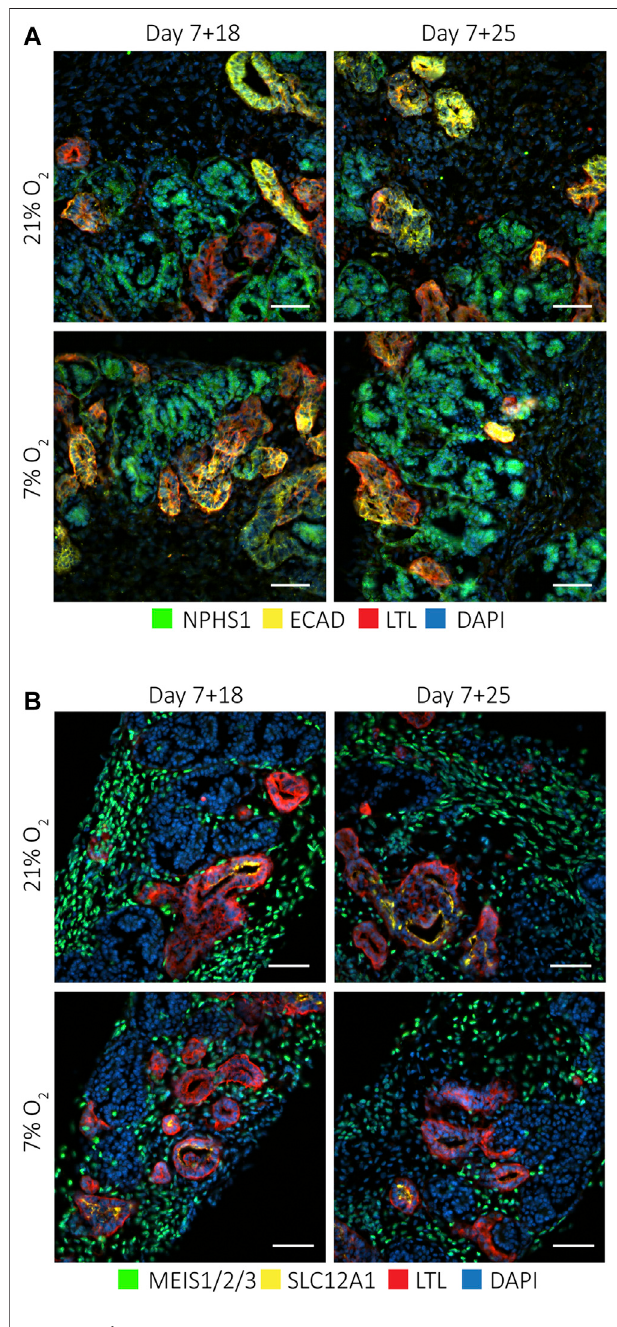
FIGURE 2 | Kidney organoids cultured at 7 and 21% O 2 develop the same cell types. Immuno fl uorescence staining for (A) . podocytes (NPHS1; green),proximaltubules(LTL;red)anddistaltubules(ECAD;yellow)andnuclei (DAPI; blue), and (B) . interstitial cells (MEIS1/2/3; green), loop of Henle (SLC12A1;yellow)andproximaltubules(LTL;red),showedthesedifferentcell types in all conditions. ( n = 3, N = 3). Scale bars: 50 µm.